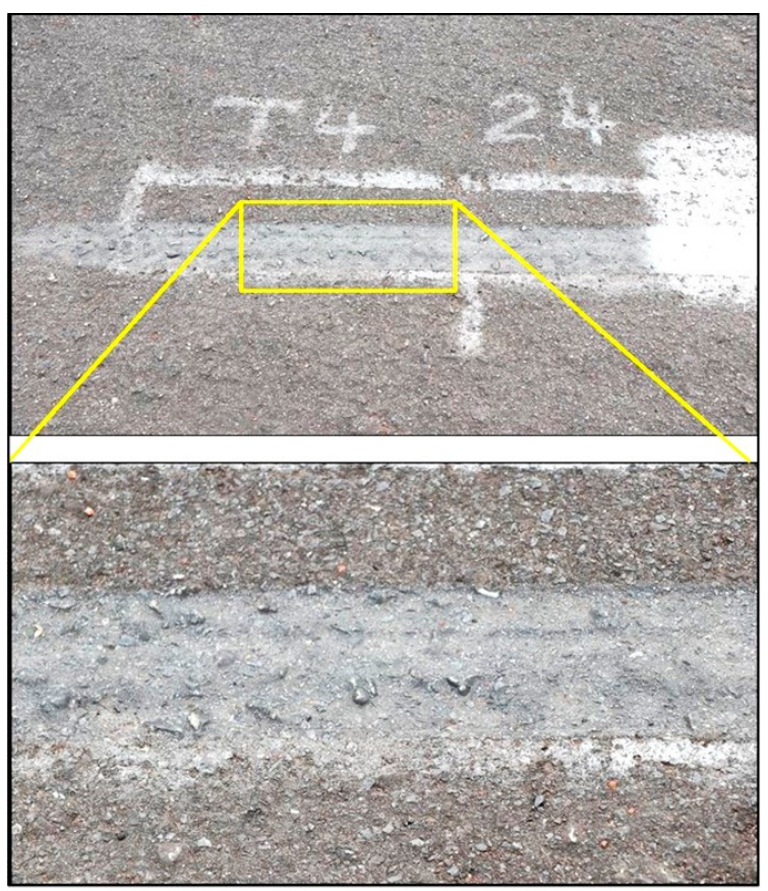
Figure 15. Condition of the Cape seal after a full-scale 24 h MMLS3 (APT) test at 50 °C applying 100,000 load repetitions. Table 5. Summary of the rut depth measurements at various positions and repetitions of the